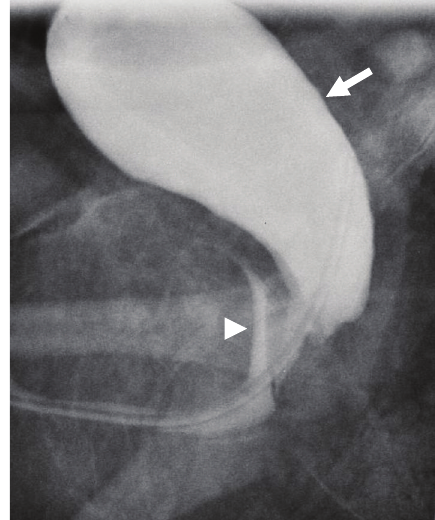
Figure 2: Lateral VCUG demonstrating catheterization of the giant prostatic utricle (white arrow) with retrograde opacification of the urinary bladder (white